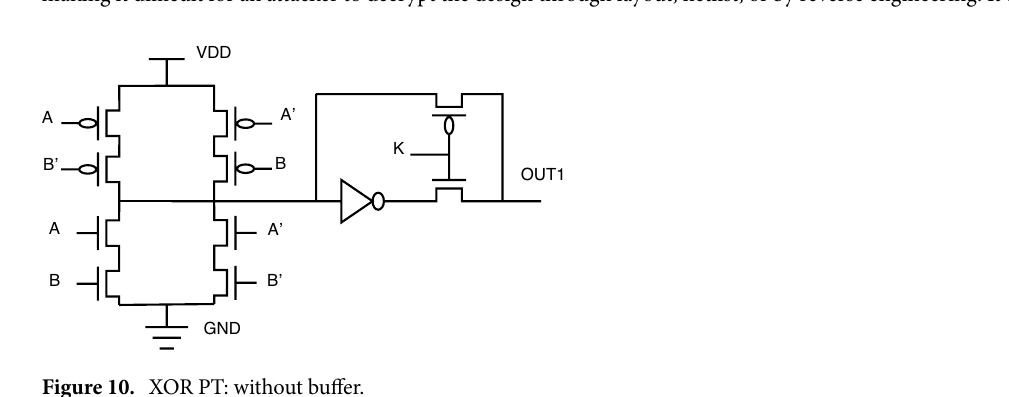
Figure 10. XOR PT: without buffer.